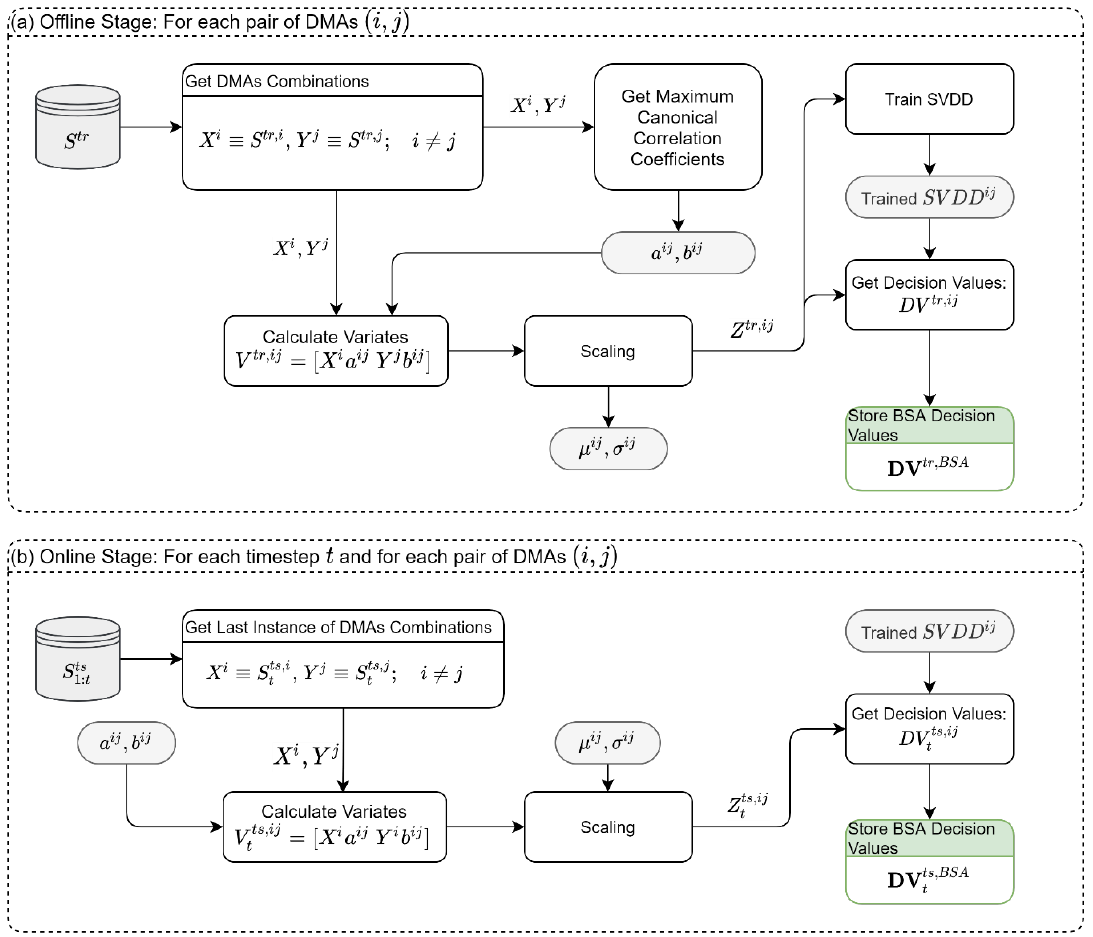
Figure 4. Between-DMA spatial analysis module: ( a ) Offline Stage, ( b ) Online Stage. Notes: Gray shade is the data created in the Offline Stage and used in the Online Stage; Green shade is the data used in the synthesis module.